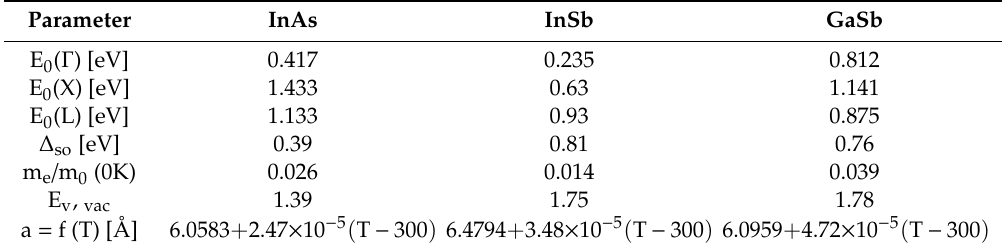
Table 1. Material parameters of InAs, InSb and GaSb layers used in simulation.